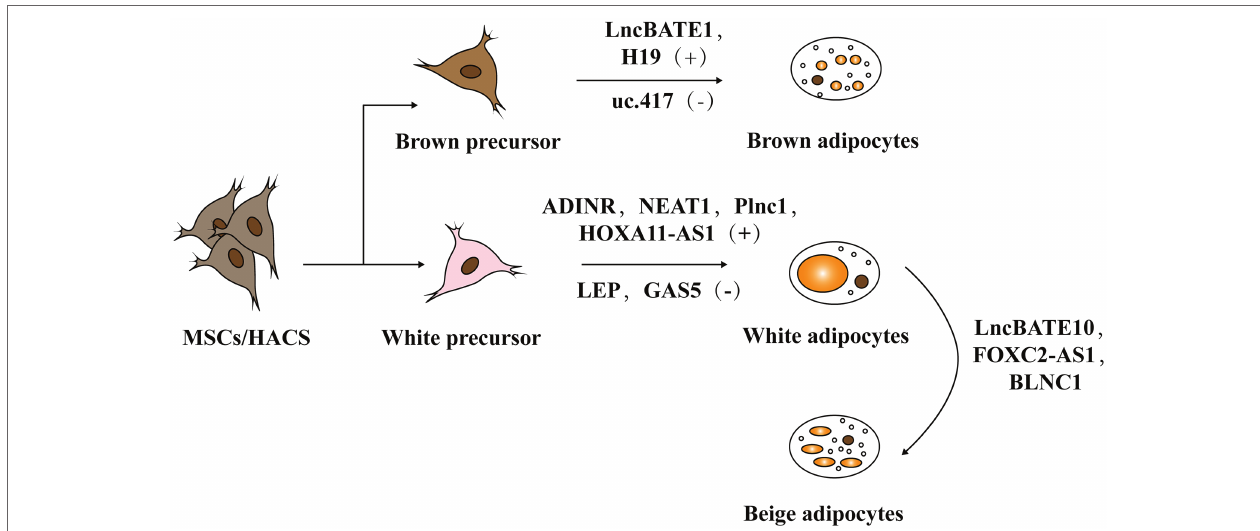
FIGURE 3 | The role of lncRNA in adipogenesis. Adipogenesis mainly includes two stages: mesenchymal stem cells (MSCs) or human adipose tissue-derived stem cells (hASCs) in adipose tissue differentiate into adipose progenitor cells and further into preadipocytes. In the second stage, preadipocytes differentiate into mature adipocytes including white adipose tissue (WAT) and brown adipose tissue